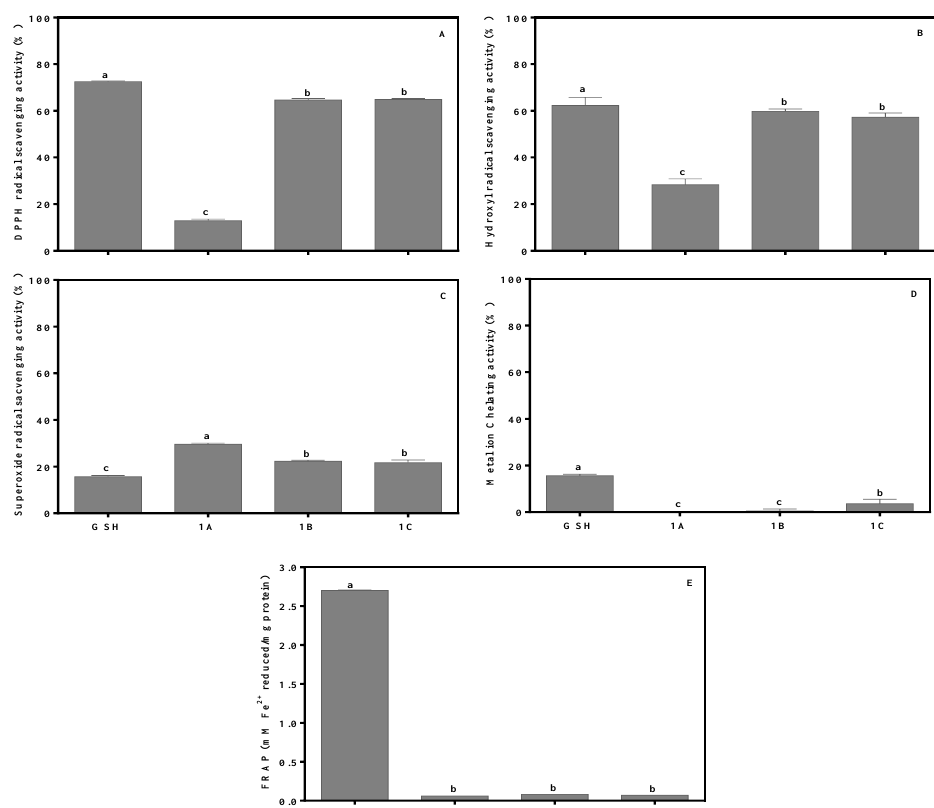
Figure 4. Antioxidant activities of P1 fractions derived from the second round of RP(C12)HPLC (1A–1C): DPPH scaveng- ing activity ( A ), hydroxyl radical scavenging activity ( B ), superoxide radical scavenging activity ( C ), metal ion chelation activity ( D ), and FRAP €. Data are expressed as mean ± standard deviation ( n = 3). a,b,c Different letters indicate signifi- cantly different mean values ( p <